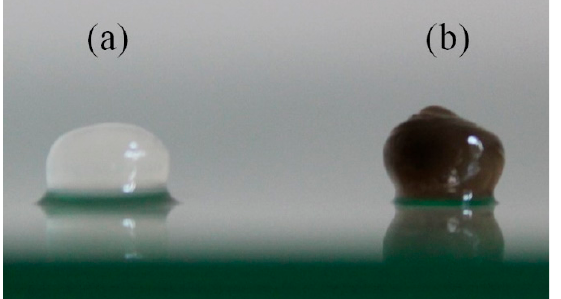
Figure 6. Contact angle with the surface of ( a ) chitosan and ( b ) chitosan with AgNPs pellets.